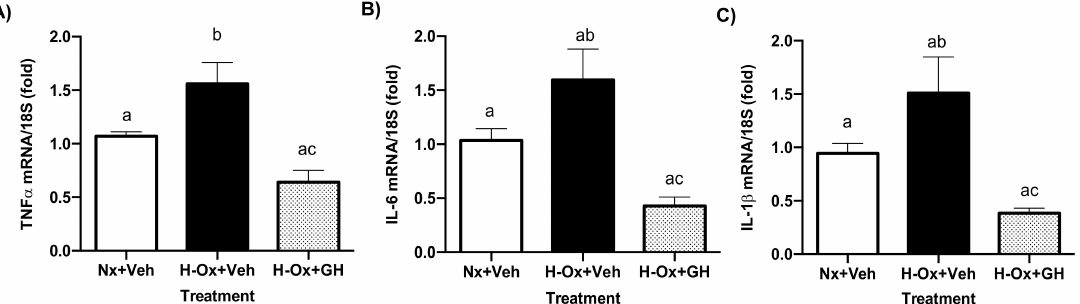
Figure 7. Effects of hypoxia and GH treatment upon the expression of mRNAs encoding for the proinflammatory mediators TNF a , IL-6, and IL-1 β in the embryonic chicken cerebellum. The relative expressions of ( A ) TNF a , ( B ) IL-6, and ( C ) IL-1 β mRNAs were determined by qPCR. Ribosomal 18S RNA was used as housekeeping gene control. Bars represent the mean ± SEM, n = 5 independent experiments by duplicate. Groups with different letters are significantly different by one-way ANOVA and Tukey’s post hoc test ( p < 0.05).